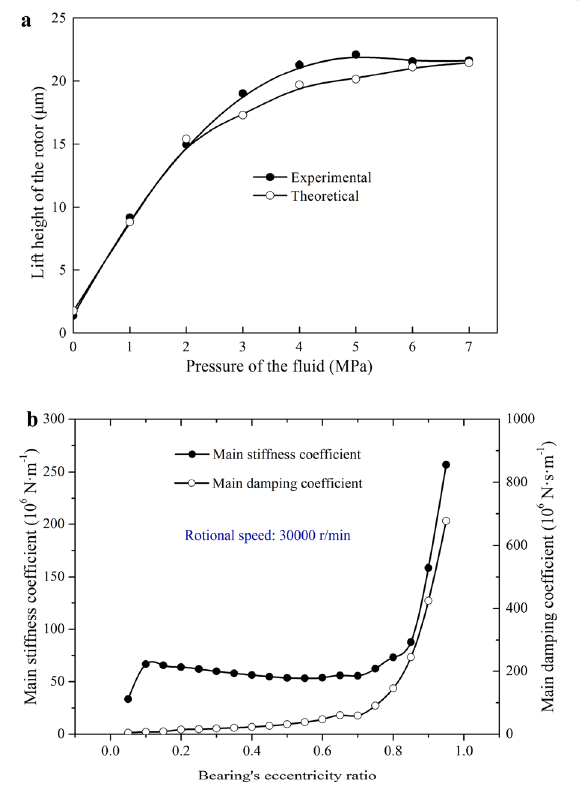
Figure 8 a Lift height of the rotor support by a fluid-film bearing, b dynamic characteristics of the fluid-film bearing